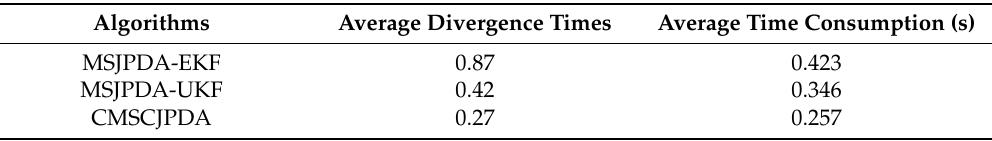
Table 3. Performance comparison of the three algorithms.